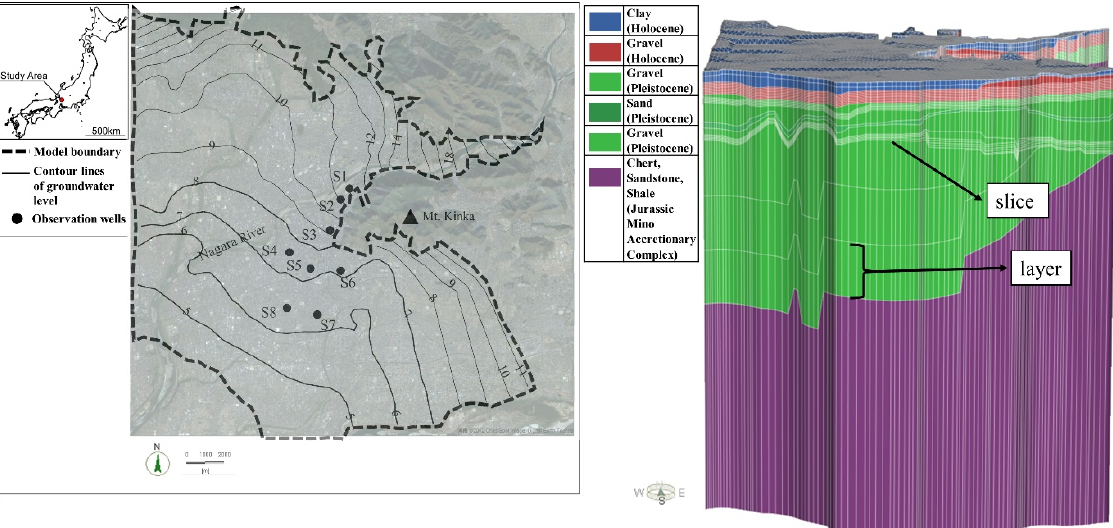
Figure 4. ( Left ) Model study area and measured hydraulic head distribution in winter (Gifu city). ( Right ) 3D geological